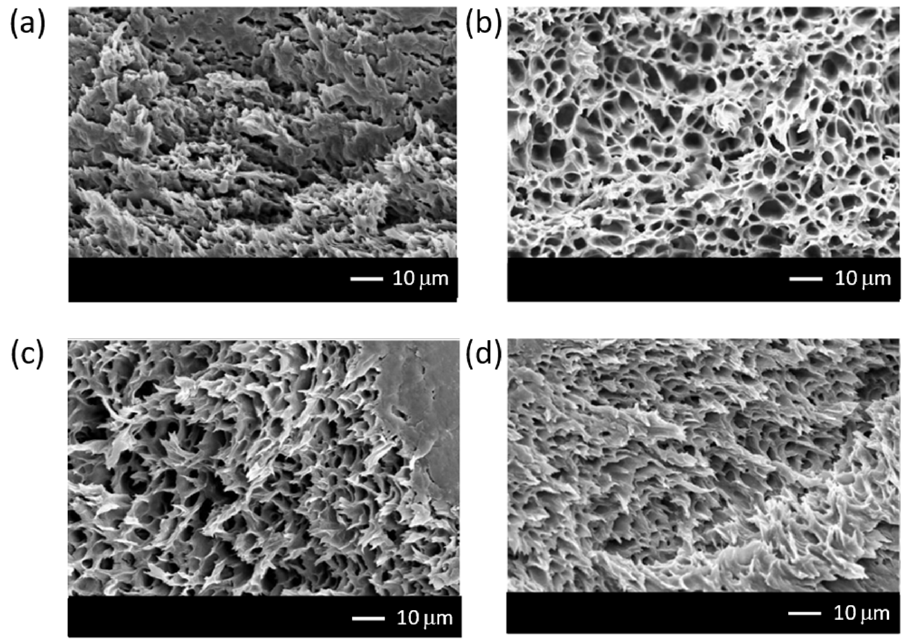
Figure 1. The cross-sectional Scanning Electron Microscopy (SEM) images of chitosan/PEG/CNT/BKC nanocomposite membranes: ( a ) M0, ( b ) M50, ( c ) M100, and ( d ) M400.